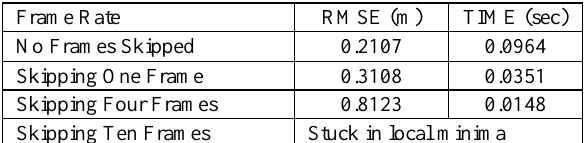
Table 1. First Experiment ICP Results